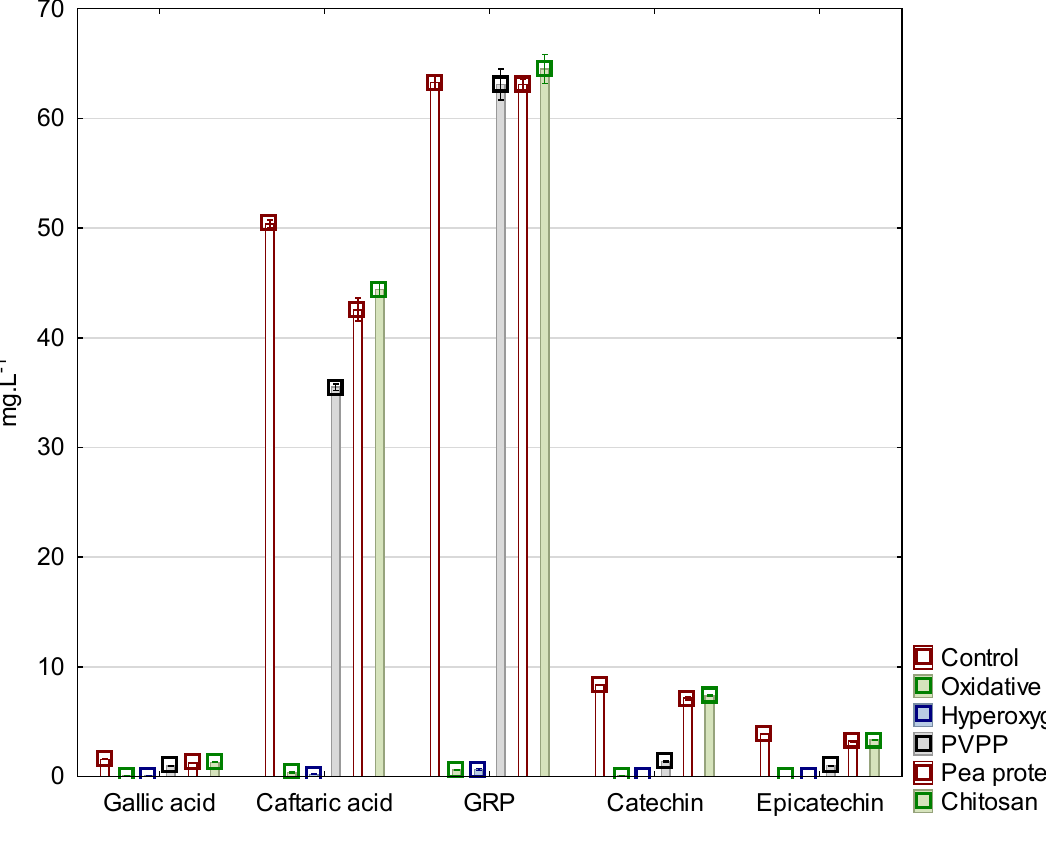
Figure 3. Comparison of selected phenolic compounds in individual variants of must from. The average values (n = 3) were combined by contribution into homogeneous groups according to Fisher´s Least significant difference (LSD) test, where different letters in the same row indicate significant differences between individual variants (α = 0.05) (Table 2).